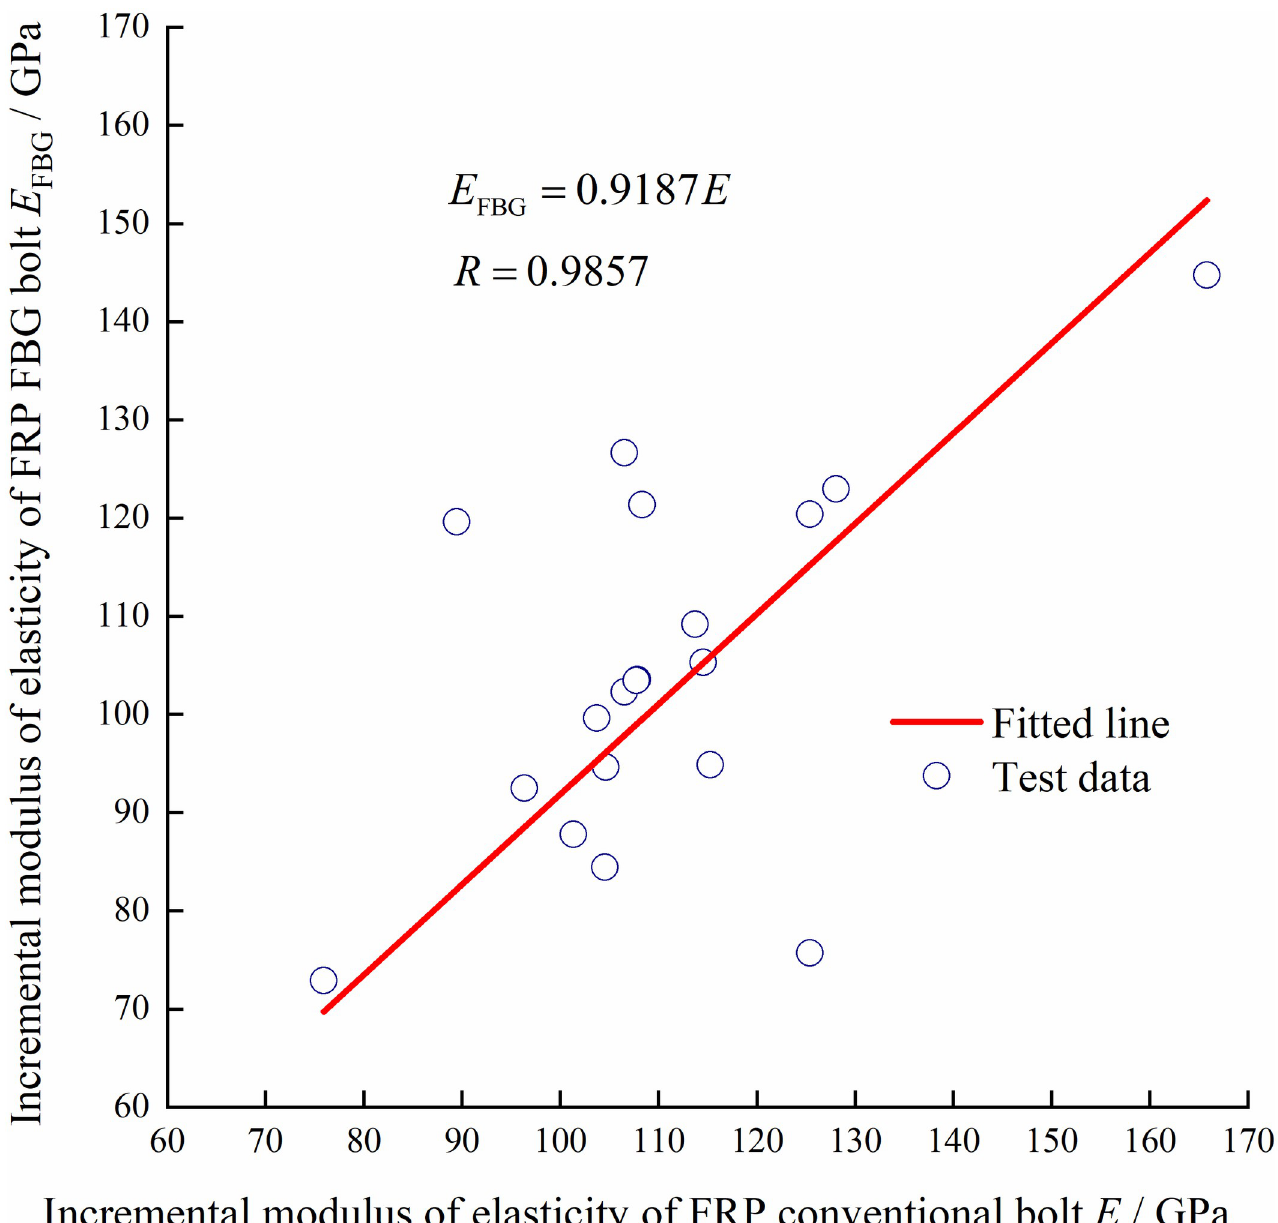
Fig 13. FRP conventional bolt incremental elastic modulus relation